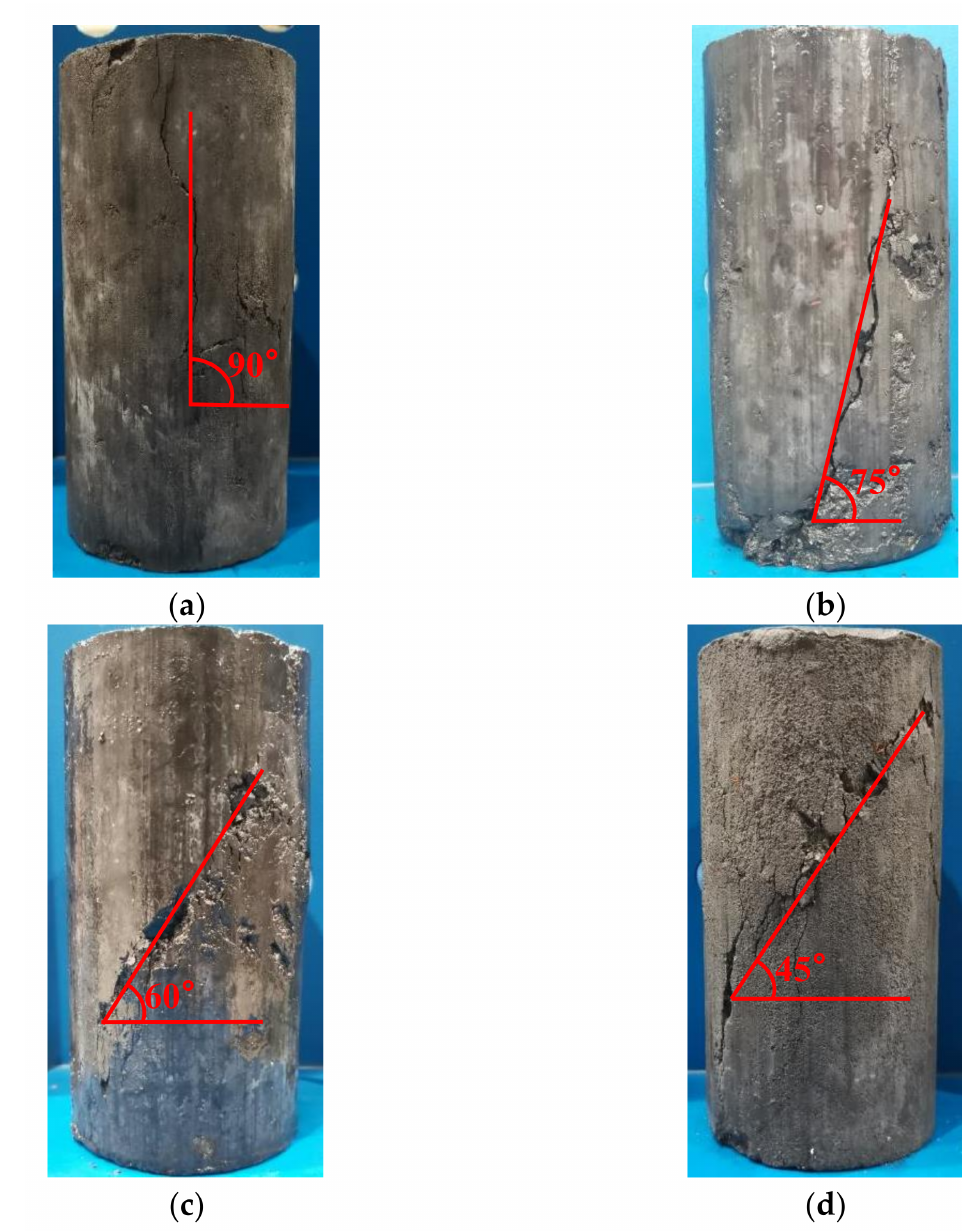
Figure 9. Failure modes of a specimen under different confining pressures: ( a ) σ 2 = σ 3 = 0, ( b ) σ 2 = σ 3 = 0.5 MPa, ( c ) σ 2 = σ 3 = 1 MPa, and ( d ) σ 2 = σ 3 = 1.5